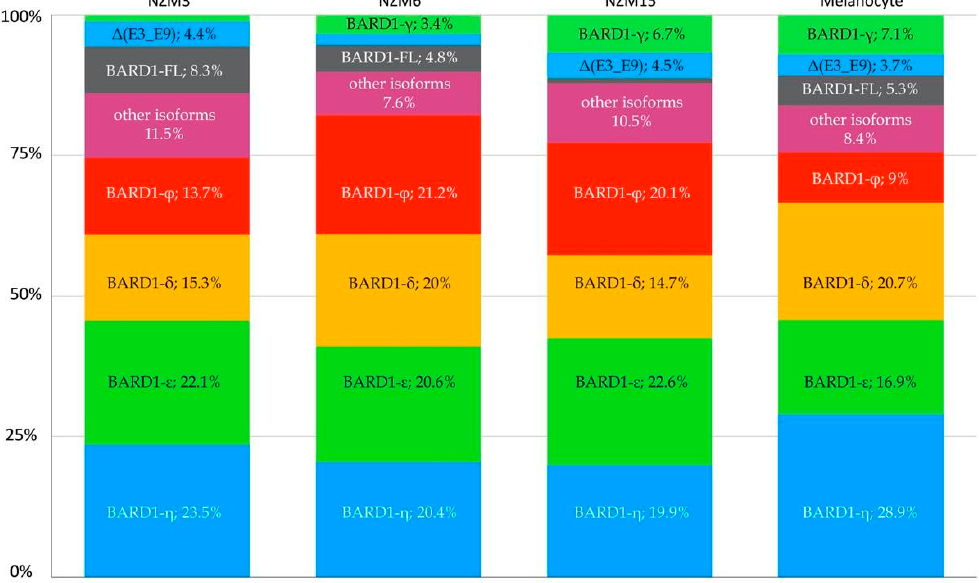
Figure 2. Proportion of BARD1 transcript isoforms quantified using nanopore sequencing. The first three bars correspond to the New Zealand melanoma (NZM) cell lines, and the last bar corresponds to the non-malignant (melanocyte)